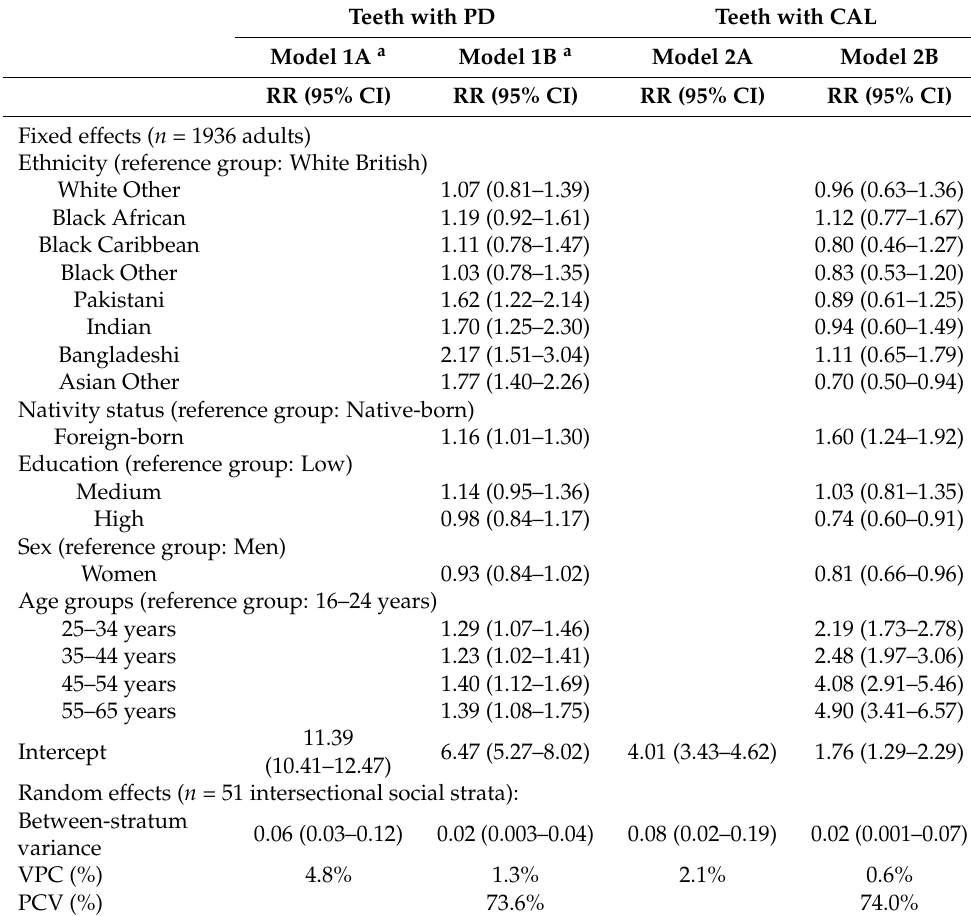
Table 2. Results from the cross-classified multilevel analysis of individual heterogeneity and discrim- inatory accuracy (MAIHDA) for periodontal measures ( n =